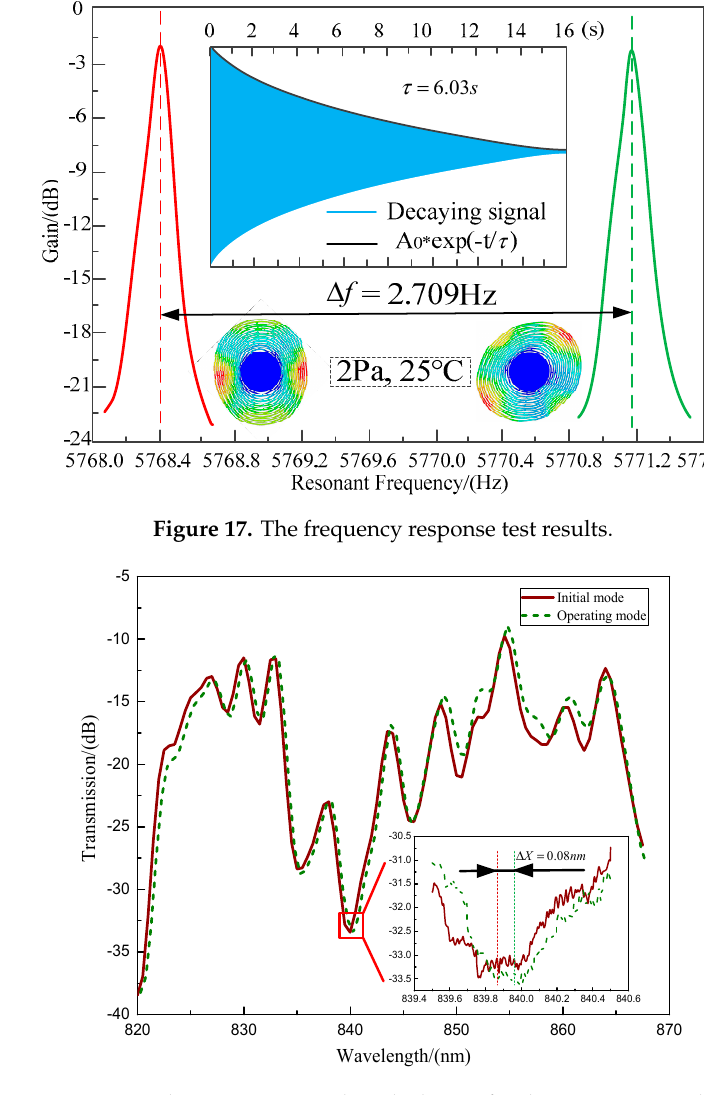
Figure 18. The resonant wavelength change for the operating mode.